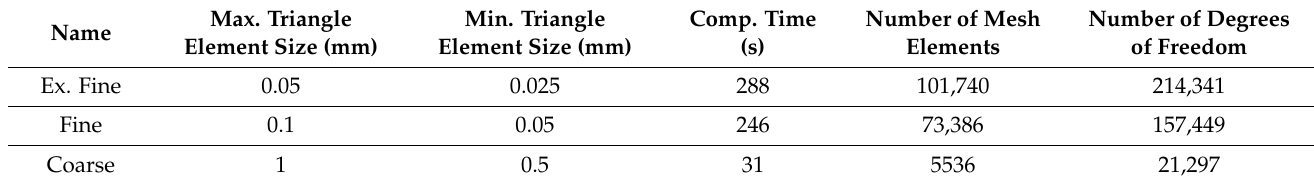
Table 3. Parameters for mesh quality check and computational Figure 3. Mesh convergence evaluation under the nozzle. Black—extremely fine Mesh; blue—fine mesh; red—coarse mesh.